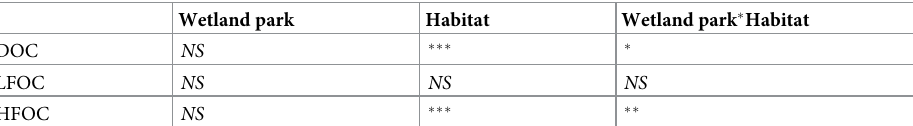
Table 1. ANOVA analysis of three forms of